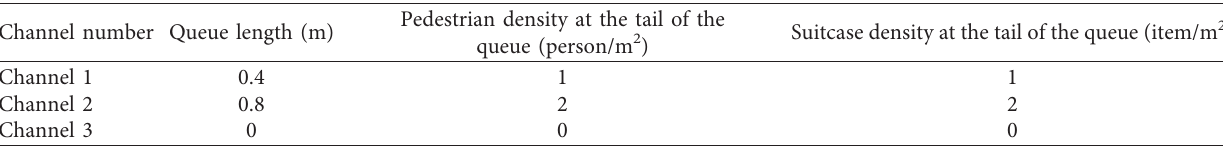
Table 4: Original information of each